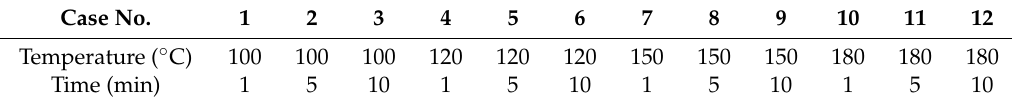
Table 2. Experiment plans to observe curing per curing process conditions of phosphor films. Case